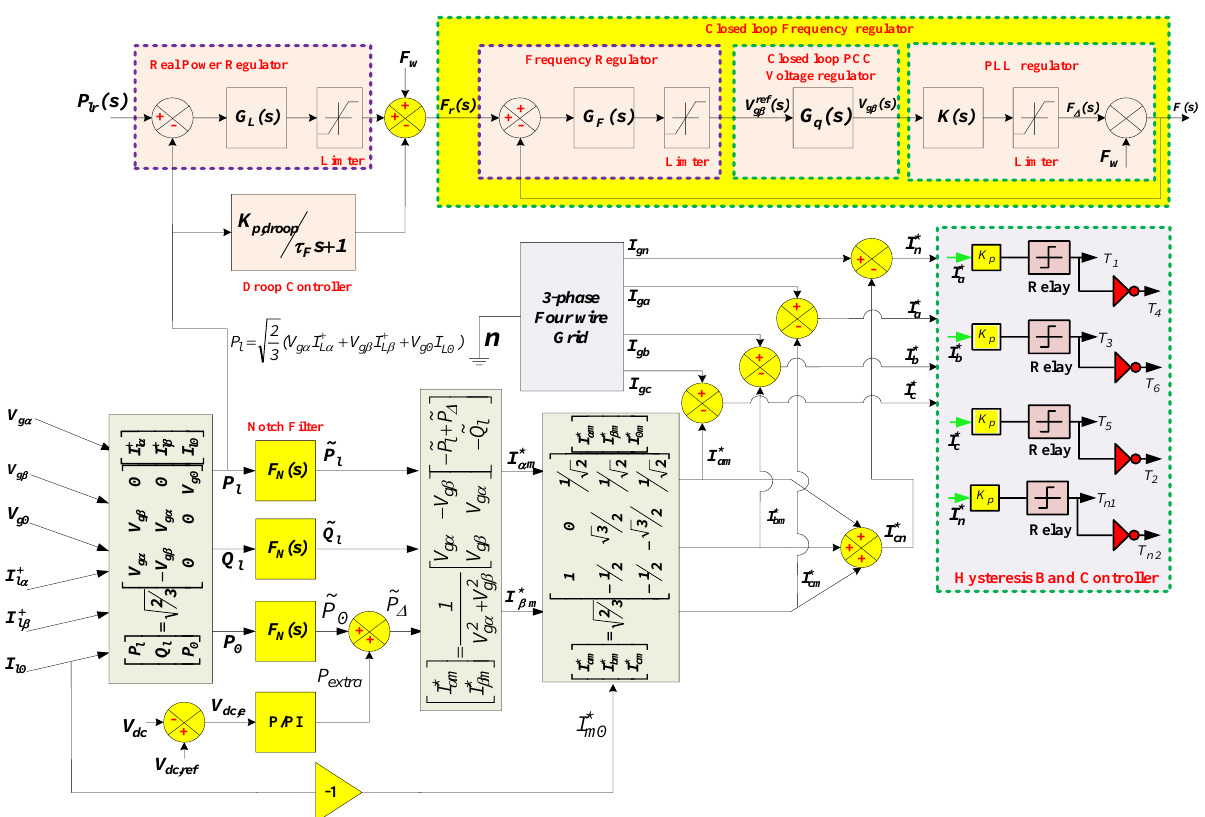
Figure 3. Proposed NHCT control architecture. ✓ Regulator Selection: As one of the open-loop poles is already at the origin, the system achieves zero steady-state error conditions easily. Therefore, for harmonic elimination or avoidance of any uncertainty condition, the applications of the proportional controller have gained interest [19,26]. A higher value of the proportional gain is selected for faster system response, and a lower value is chosen to improve the system ’ s stability during any transient conditions. In these circumstances, the proportional integral regulators (PIR) are also preferred at one condition by avoiding the chances of pure integrator conditions; otherwise, the system loses its stability. To guarantee zero steady-state error, all the regulators used in the NCVC are generally PIRs. The zero of the PIRs is selected so that it cancels out the close to origin pole of the open-loop system. The selection of the PIR gain ‘ K ’ occurs in such a way that, for a more significant value, it gives a faster response. In addition, it limits the peak overshoot to a safer limit (if the root locus is drawn, for a stable reply, all the closed-loop poles are present on the left side of the s-plane at all PIR gain values). All the regulators of the current controllers are presented as